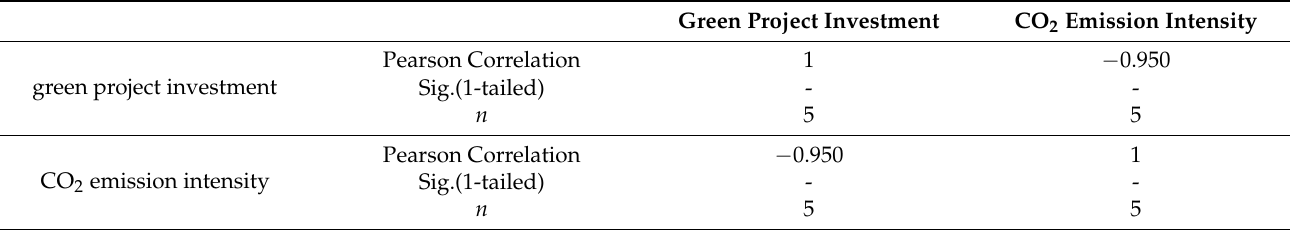
Table 5. Correlation between green project investment and CO 2 emission